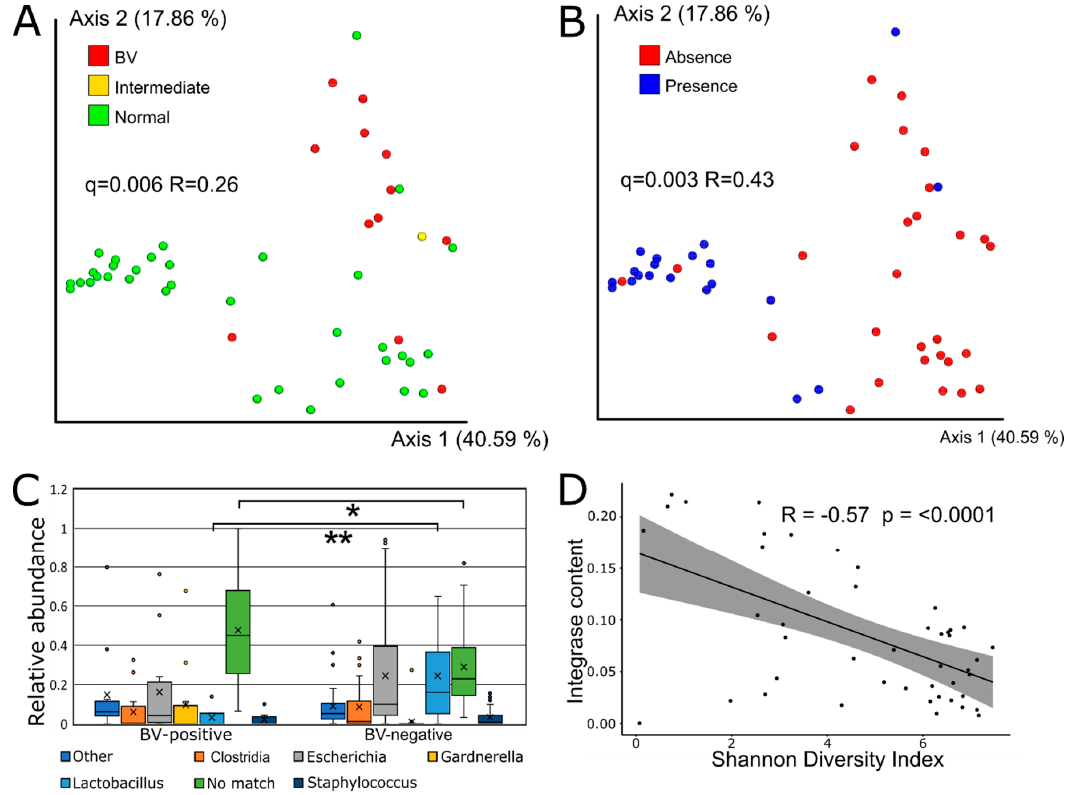
Figure 2. The vaginal viral community was significantly correlated with the BV-status. ( A ) Vaginal virome composition (Bray Curtis dissimilarity metric) by BV-status and ( B ) Lactobacillus crispatus presence / absence (determined by qPCR). ( C ) The relative abundance of WISH host genus predictions of vOTUs by BV status. The significance was calculated using the Kruskall–Wallis Test (* p < 0.05, ** p < 10 − 3 ). ( D ) A scatter plot showing the Shannon diversity against the percentage of raw reads mapping to integrase genes by sample. Significance levels were calculated using the Pearson correlation.